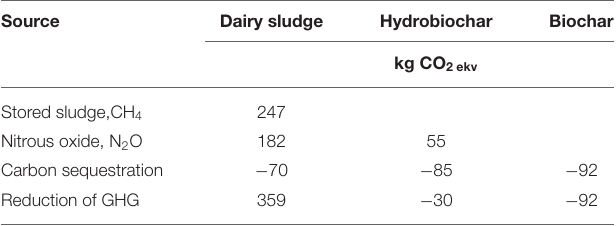
TABLE 6 | Greenhouse gas emission from the management chain of dairy sludge management untreated and after HTC or pyrolysis—calculated in the present